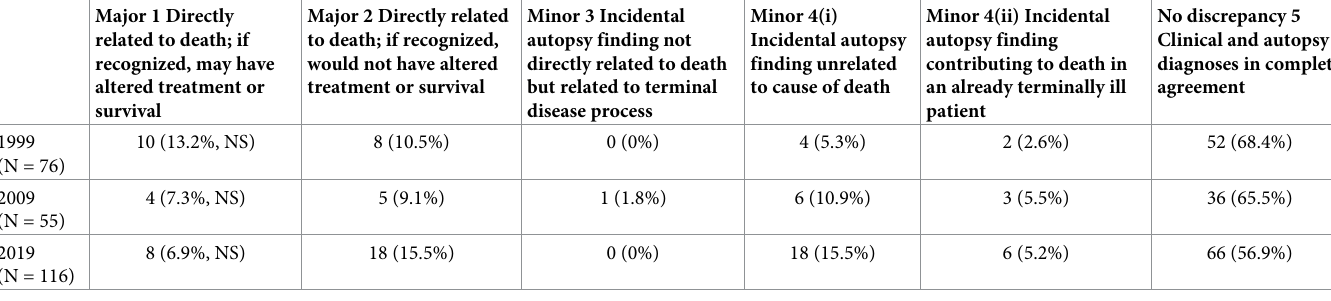
Table 3. Goldman agreement classification between antemortem clinical diagnosis and autopsy diagnosis in 1999, 2009 and